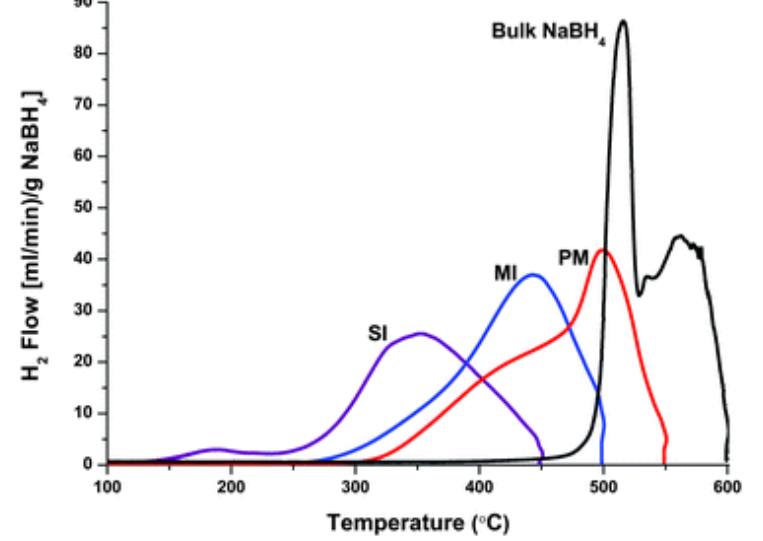
Figure 3. TPD experiments (5 °C·min −1 under Ar) showing hydrogen release from bulk NaBH 4 (black); a physical mixture of 25 wt% NaBH 4 and porous carbon (PM; red); solution impregnated 25 wt% NaBH 4 /C nanocomposites (SI; purple) and melt infiltration (MI; blue) 25 wt% NaBH 4 /C nanocomposites [29]. Reproduced from [29] with permission of The Royal Society of